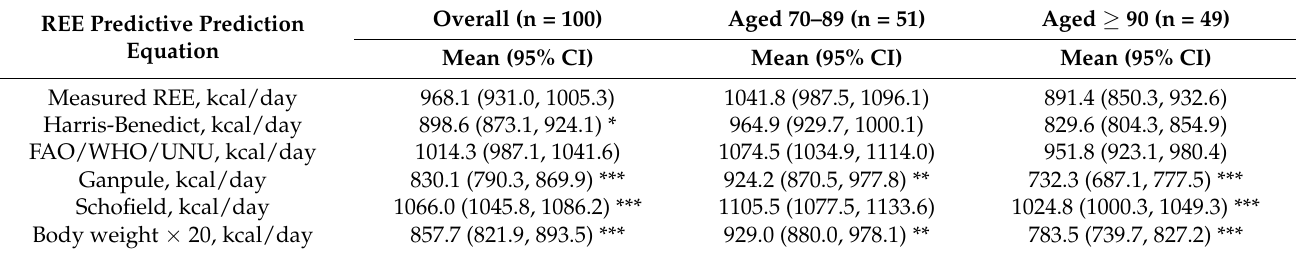
Table 3. Evaluation of resting energy expenditure (REE) predictive prediction